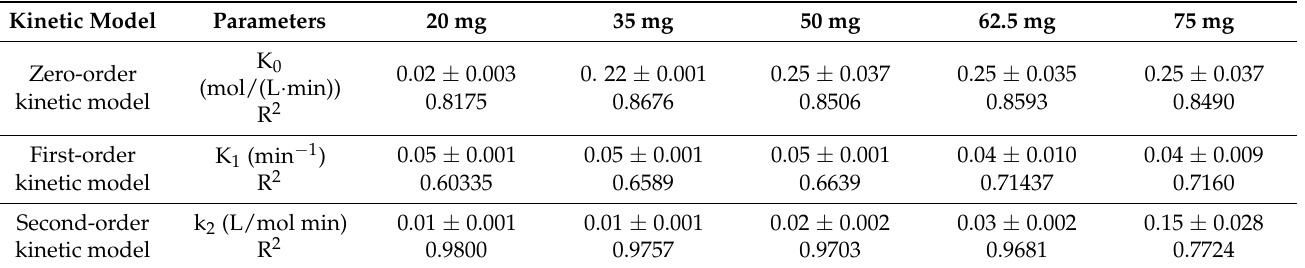
Table 3. The zero-, first-, and second-order kinetic parameters using 10 mg/L MB for photodegrada- tion of MB of different concentrations.